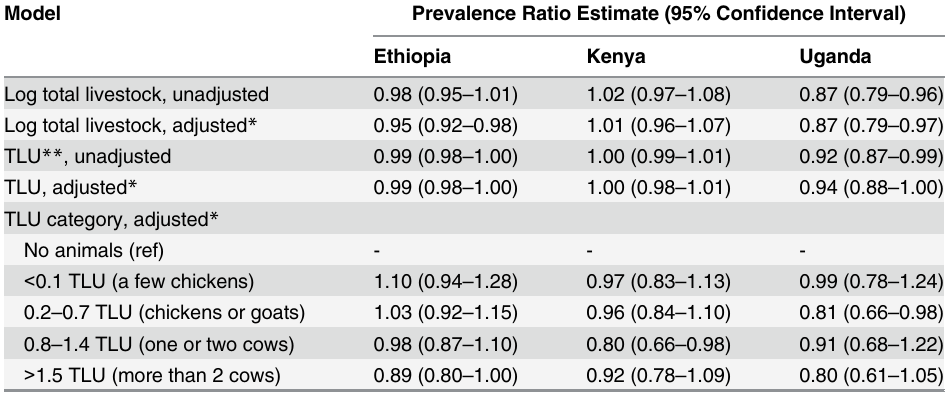
Table 2. Log-binomial models for the relationship between household livestock ownership and stunt- ing prevalence in Ethiopia, Kenya, and Uganda. Model